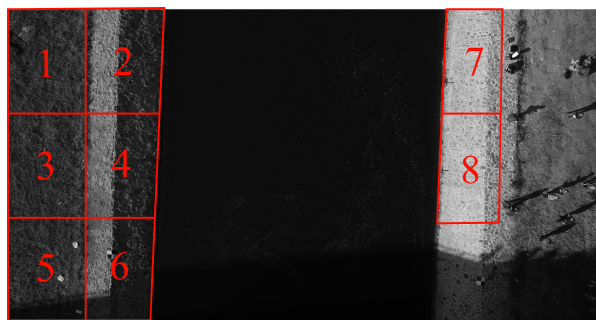
Figure 7. Subregions in the SVF analysis for the Kolubara river case